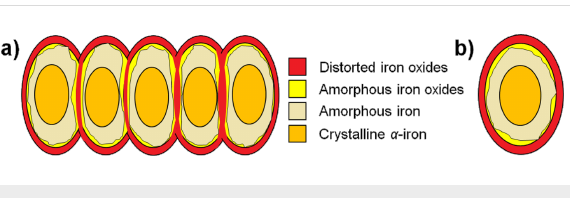
Figure 5: Scheme of a) iron nanowires and b) iron nanoparticles with regards to structural experimental results.